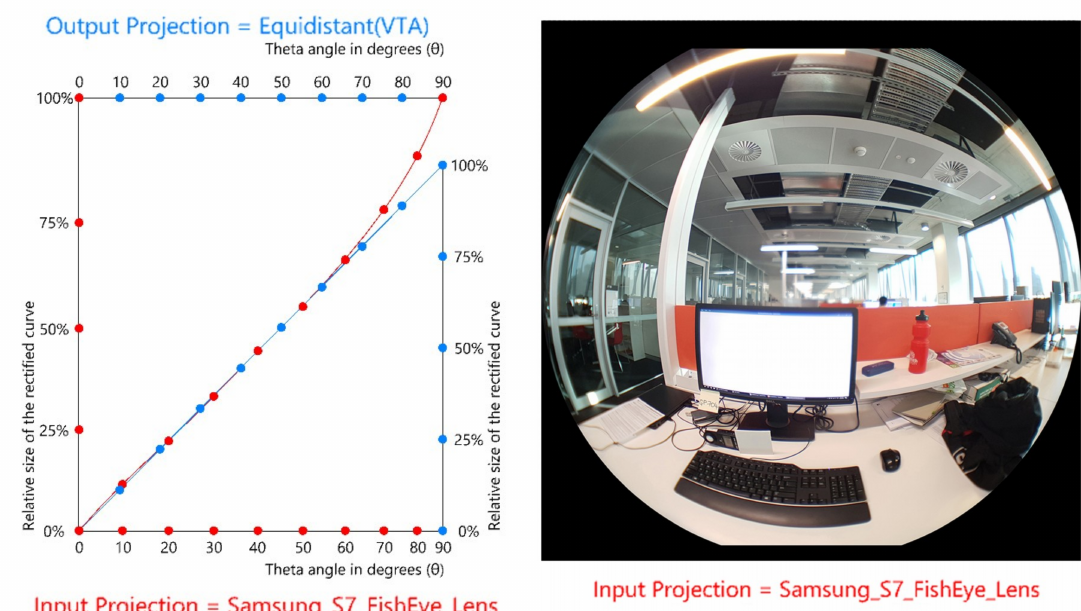
Figure 10. On the left a graph shows the relation between the rectified curve of Samsung Galaxy S7 and the rectified curve of equidistant projection. The figure on the right shows the test scene and the projection rings of the smart phone with fisheye lens